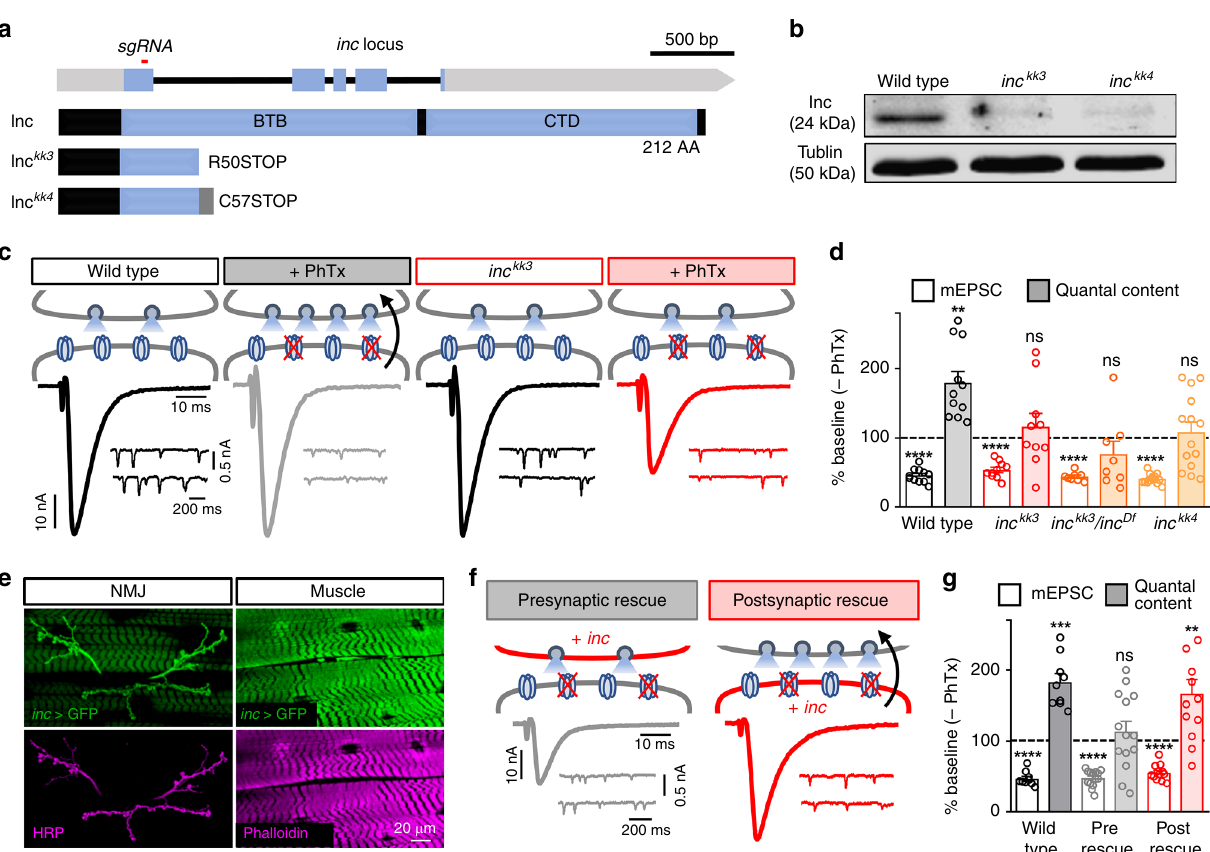
Fig. 2 inc is required in the postsynaptic compartment to drive retrograde PHP signaling. a Schematic of the Drosophila inc locus, with the region targeted by the single guide RNA to generate the inc kk3 and inc kk4 alleles shown. (Bottom) Structure of Inc and the predicted structure of the inc kk3 and inc kk4 mutant alleles. b Anti-Inc immunoblot analysis from whole-adult lysates con fi rms that both inc kk3 and inc kk4 are protein null alleles. c Rapid expression of PHP requires inc . Schematic and representative EPSC and mEPSC traces for wild-type ( w 1118 ) and inc kk3 mutants before and after PhTx application. While mEPSC amplitude is reduced after PhTx application, as expected, inc kk3 mutants fail to homeostatically increase presynaptic neurotransmitter release, resulting